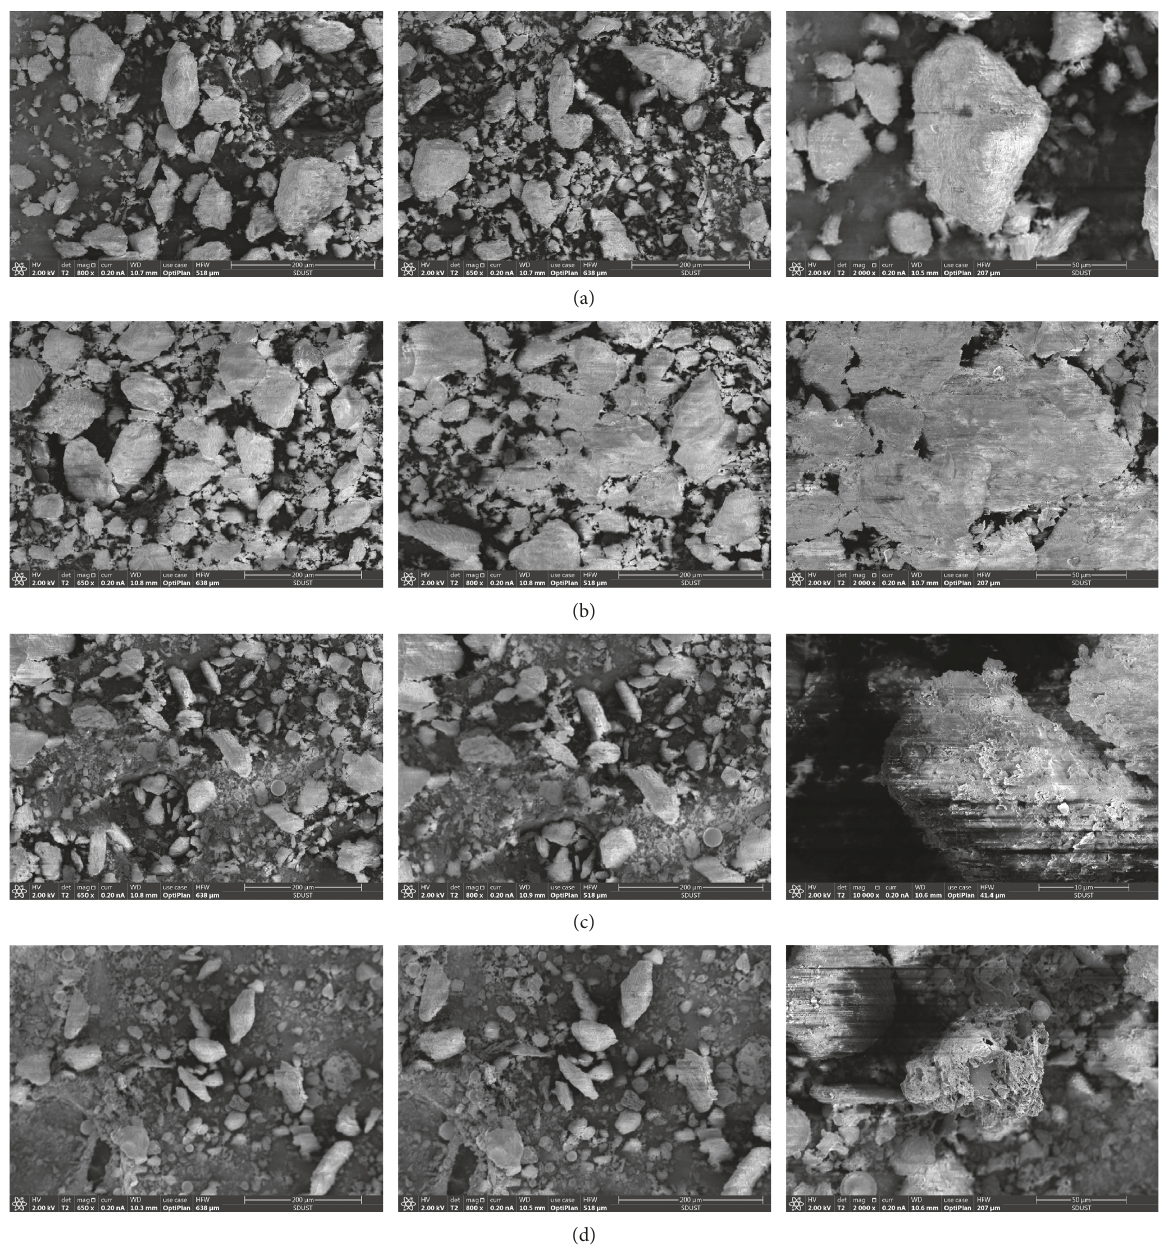
Figure 8: The SEM images of oil shale dust particles: (a) OOSD; (b) FER; (c) SER; (d)